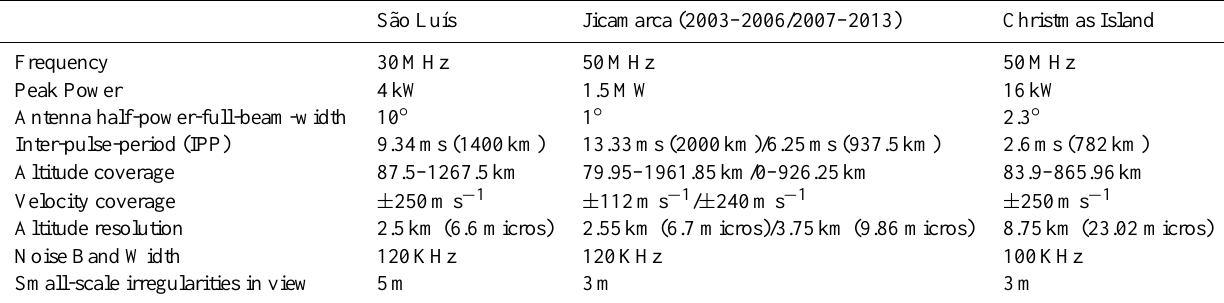
Table 2. VHF Radar specifications for the three equatorial stations in use. For Jicamarca some details are separated for 2003–2006 and 2007–2013 period.